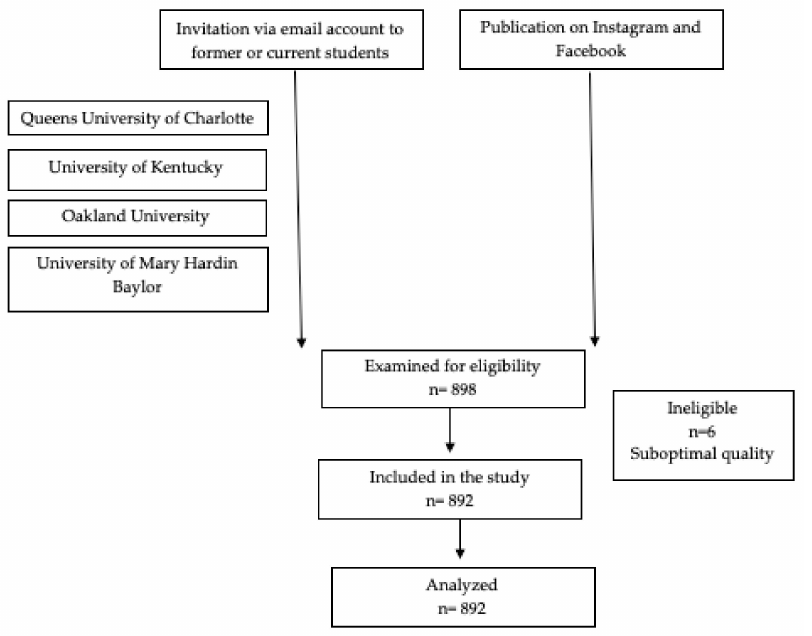
Figure 1. Flow chart of the survey